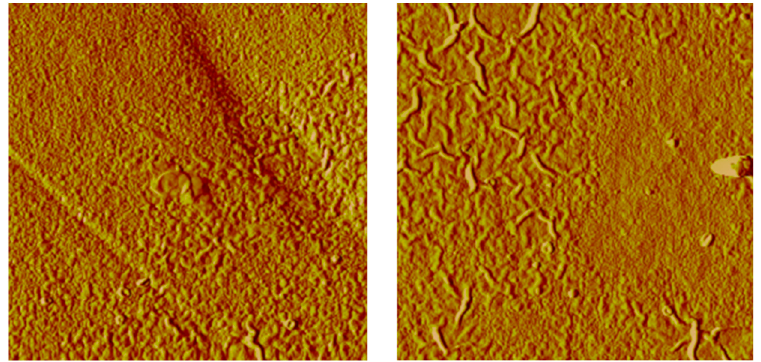
Figure 11. AFM images for M1 membrane (10 μ m). Left : new membrane. Right : membrane after chemical cleaning.